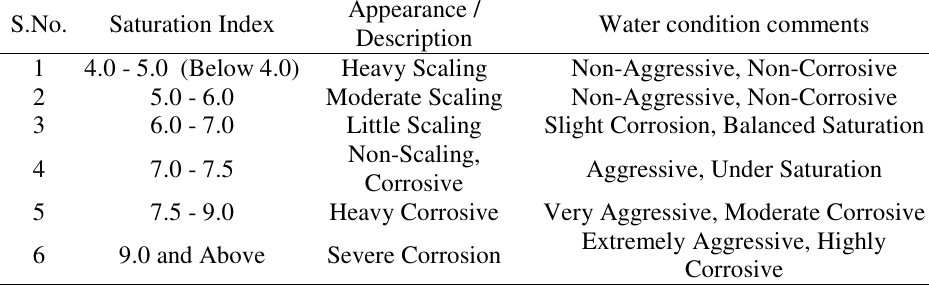
Table 5. Interpretation of Ryzner saturation index (RSI) test